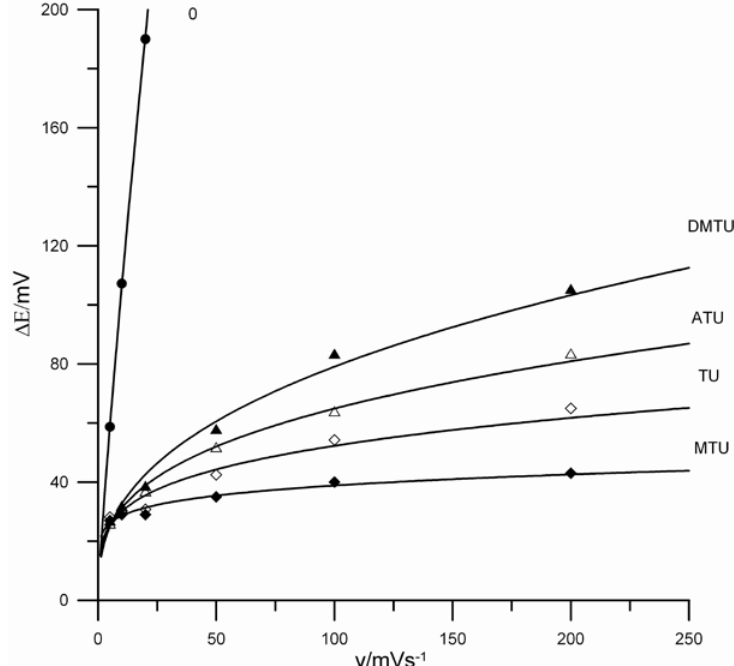
Figure 6. The influence of polarization rate on the difference between potentials of cathodic and anodic peaks for the In (III)/In(Hg) couple in 1 mol dm -3 NaClO pH 2 in the presence of 5×10 -3 mol dm -3 TU ( ◊ ) [ 45], MTU ( ♦ ), ATU ( Δ ) and DMTU ( ▲ ) [ 46] 4